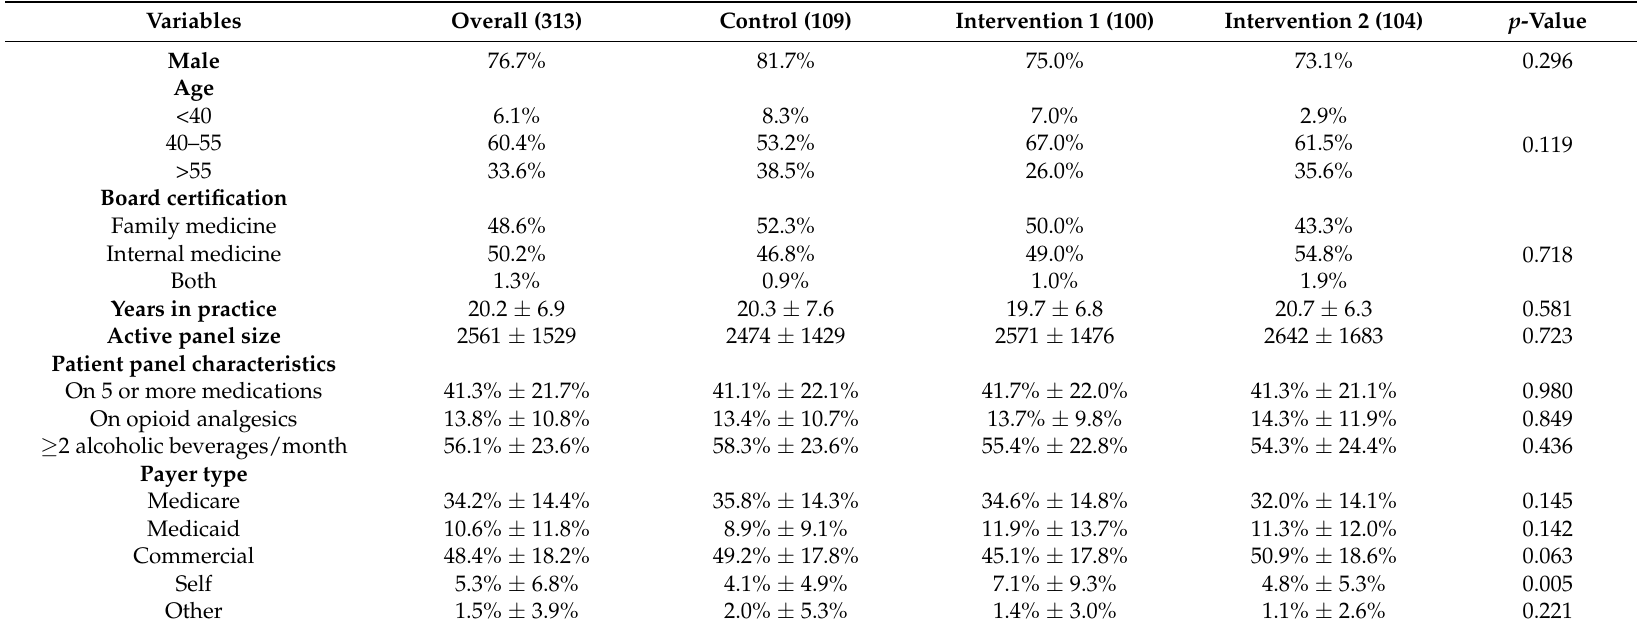
Table 1. Provider Characteristics.